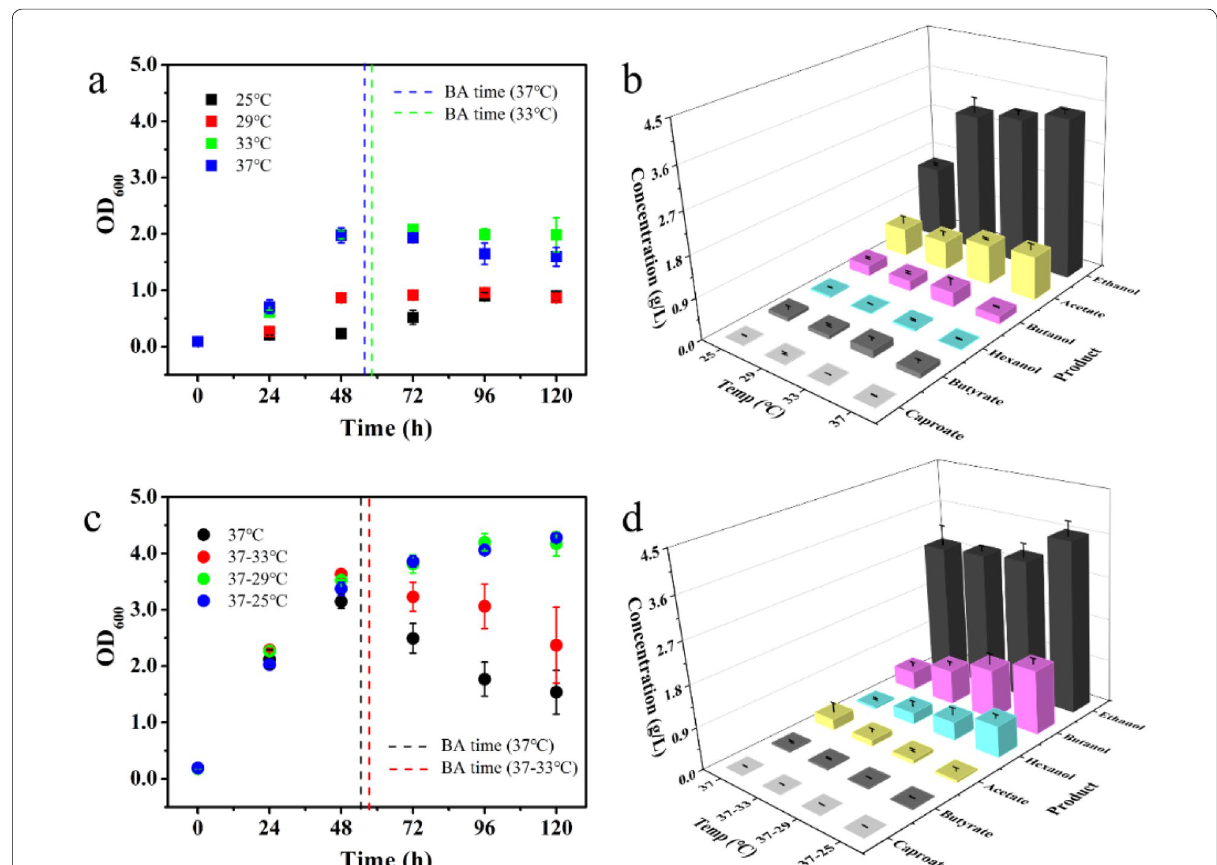
Fig. 1 Growth and production by C. carboxidivorans P7 using various temperature strategies. Mean values and standard errors of three replicates are shown in all graphs. a Optical densities at 600 nm (OD 600 s) in the culture of 25 °C, 29 °C, 33 °C and 37 °C, respectively, during 0–120 h; the approximate time when bacterial agglomerates appeared (BA time) in the culture of 33 °C and 37 °C. c OD 600 s in the culture of 37–25 °C, 37–29 °C, 37–33 °C and 37 °C, respectively, during 0–120 h; the BA time in the culture of 37 °C and 37–33 °C. b , d Titers of ethanol, butanol, hexanol, acetate, butyrate and caproate at 120 h, using various temperature